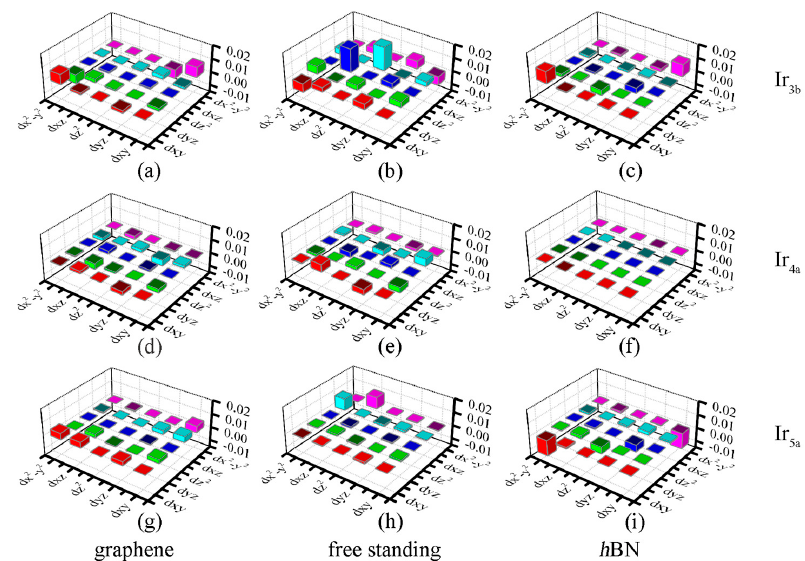
Figure 8. The angular momentum operator matrix of the d orbital of the most stable structure: (a) Ir 3b /graphene-H, (b) free − standing Ir 3b , (c) Ir 3b / h BN-TT, (d) Ir 4a /graphene-BB, (e) free − standing Ir 4a , ( a ) Ir 3b /graphene-H, ( b ) free − standing Ir 3b , ( c ) Ir 3b / h BN-TT, ( d ) Ir 4a /graphene-BB, ( e ) free − standing (f) Ir 4a / h BN-TT, (g) Ir 5a /graphene-H, (h) free − standing Ir 5a and (i) Ir 5a / h BN-H. The units of the coor- Ir 4a , ( f ) Ir 4a / h BN-TT, ( g ) Ir 5a /graphene-H, ( h ) free − standing Ir 5a and ( i ) Ir 5a / h BN-H. The units of dinates are eV. the coordinates are